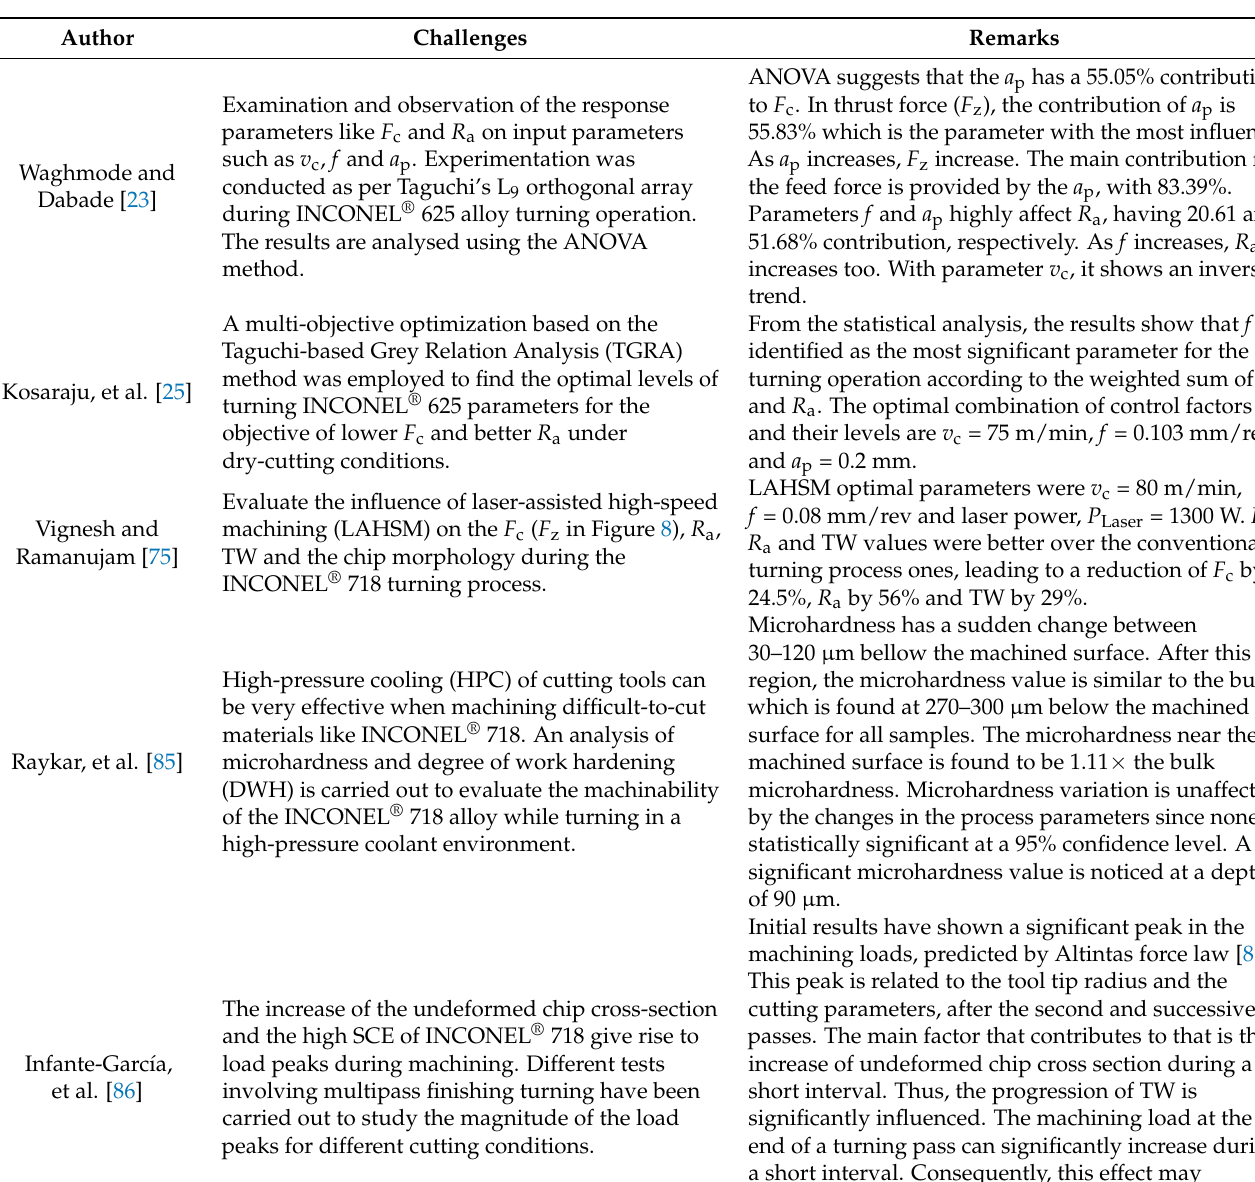
Table 7. Critical challenges and developments in the turning process of INCONEL ®